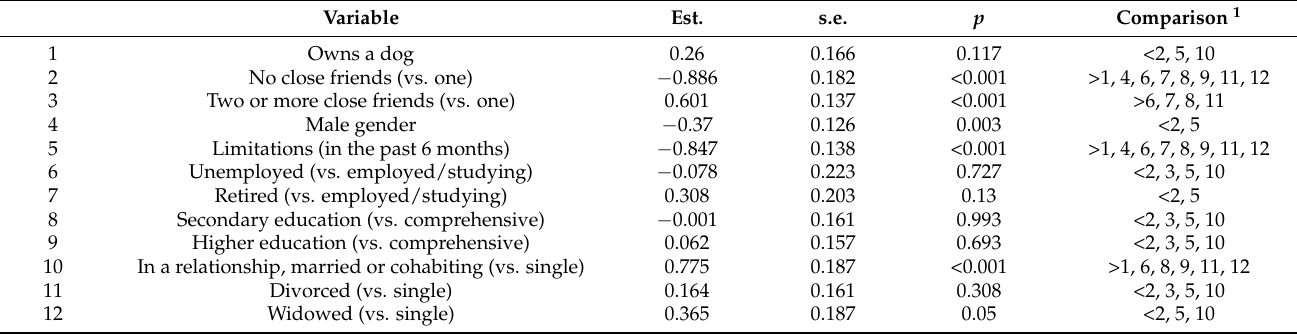
Table A3. Total unstandardized effects of circumstantial factors (excluding age) and their relative comparison. Variable Est. s.e. p Comparison